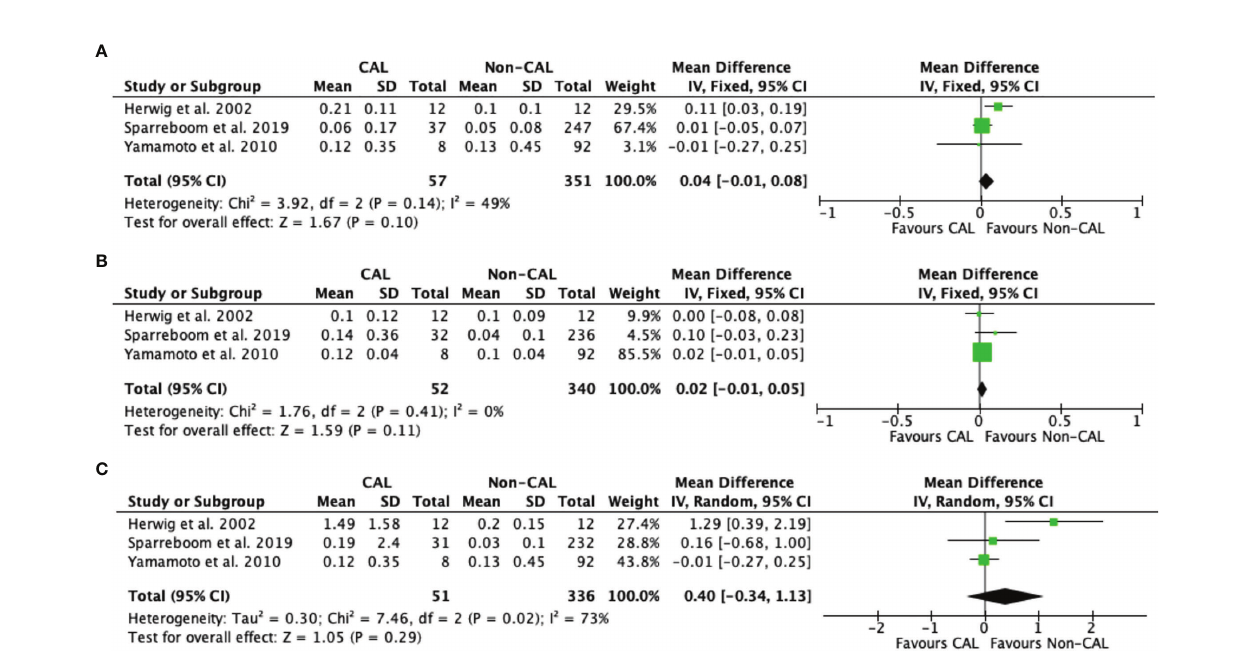
FIGURE 3 | Forest plot of peritoneal levels of IL-1 b (ng/mL) on patients with CAL and non-CAL patients each postoperative days (POD) 1 (A) , 2 (B) , and 3 (C)